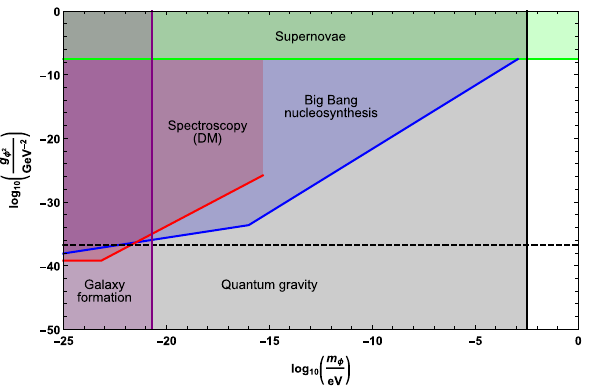
Fig. 5 Limits on the quadratic gauged scalar interaction g (cid:9) 2 = c 7 /(cid:4) 7 asafunctionofthemassofthescalar m (cid:9) .Green:limitsfromsupernovae measurements[65].Blue:limitsfromthebigbangnucleosynthesis[20]. Red: limits from atomic spectroscopy [20,24,45]. Purple: limits from galaxy formation, quasar lensing and stellar streams [48–53]. Black: limits from quantum gravity as discussed in this paper. Dashed black line: reduced Planck